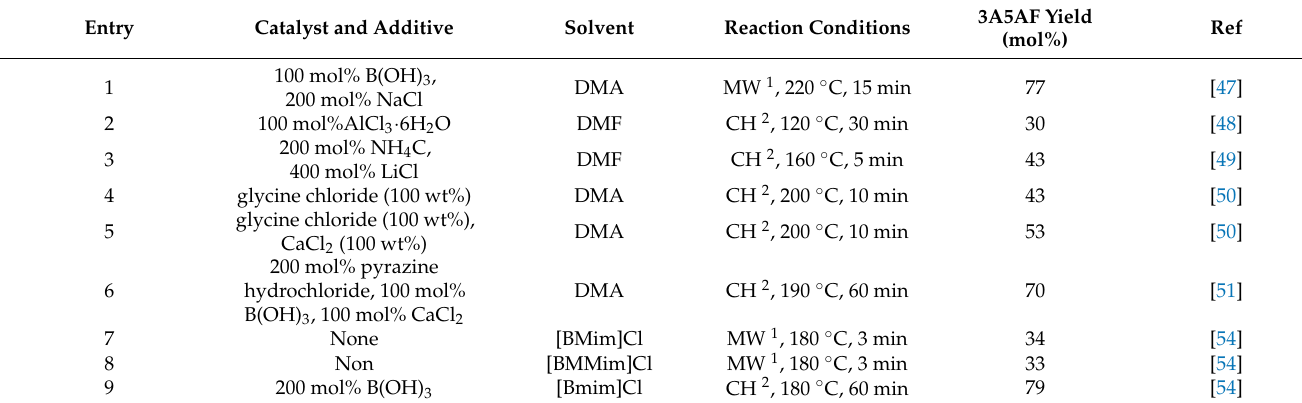
Table 4. Catalytic conversion of GlcNAc to 3A5AF.